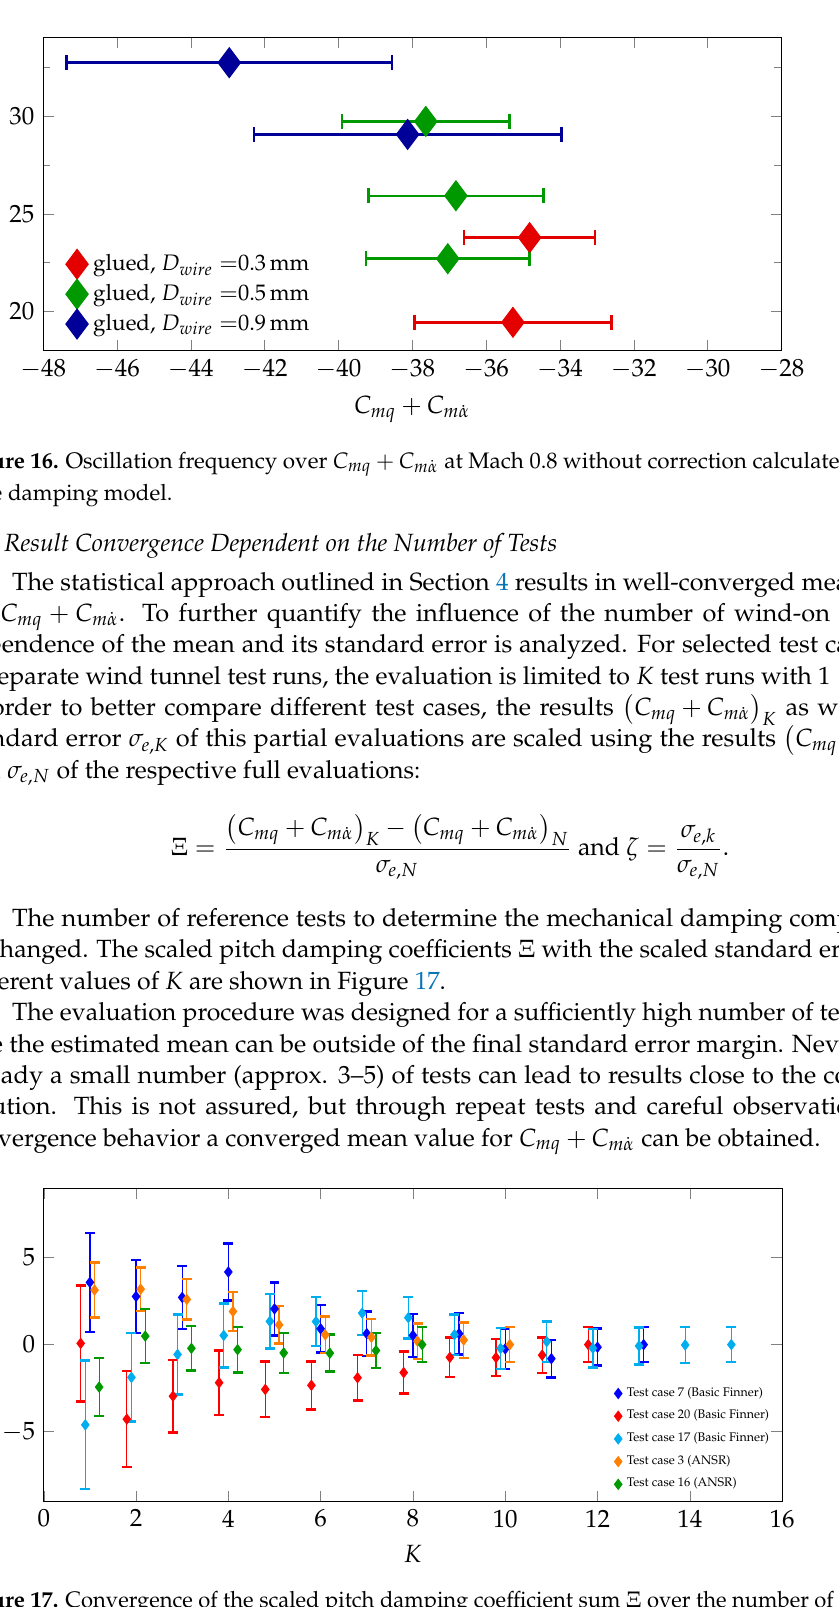
Figure 17. Convergence of the scaled pitch damping coefficient sum Ξ over the number of individual wind tunnel tests included in the evaluation for selected test